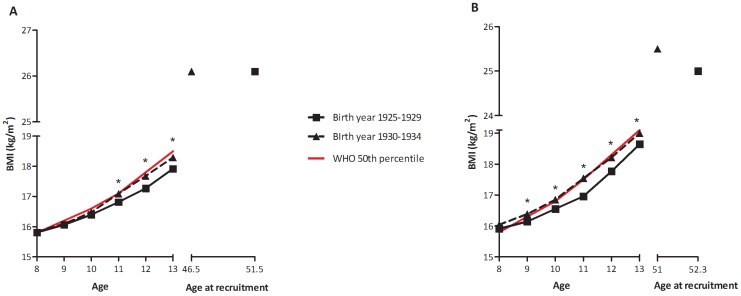
Mean BMI from 8–13 years by birth year group for A) men and B) women.Footer: Subjects born pre-Depression (1925–1929) were growing up during the Depression; while subjects born during the Depression (1930–1934) were growing up after the Depression and had faster BMI gain, growing closer to the 50th percentile for the WHO BMI-for-age standards compared to their counterparts born earlier. *Significant difference between BMI values of participants born pre-Depression vs. during the Depression, adjusted for maternal age and parity (P<0.05).